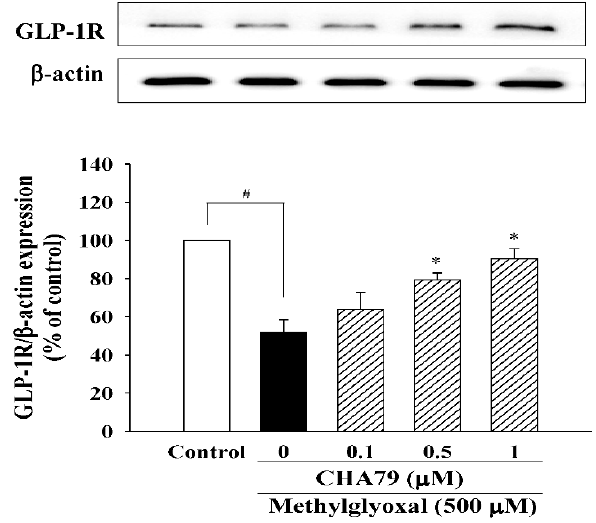
Figure 4. CHA79 up-regulated the expression of GLP-1R in MG-treated SH-SY5Y dopaminergic neurons. One-hour pre-treatment with CHA79 (0.1–1 µ M) followed by 24 h MG (500 µ M) exposure was carried out. WB data are presented as % of control follow by normalization with internal standard ( β -actin). Data are shown as mean ± SEM ( n = 6). # p < 0.05 versus the control group (vehicle control: 0.1% DMSO). * p < 0.05 versus the MG group.